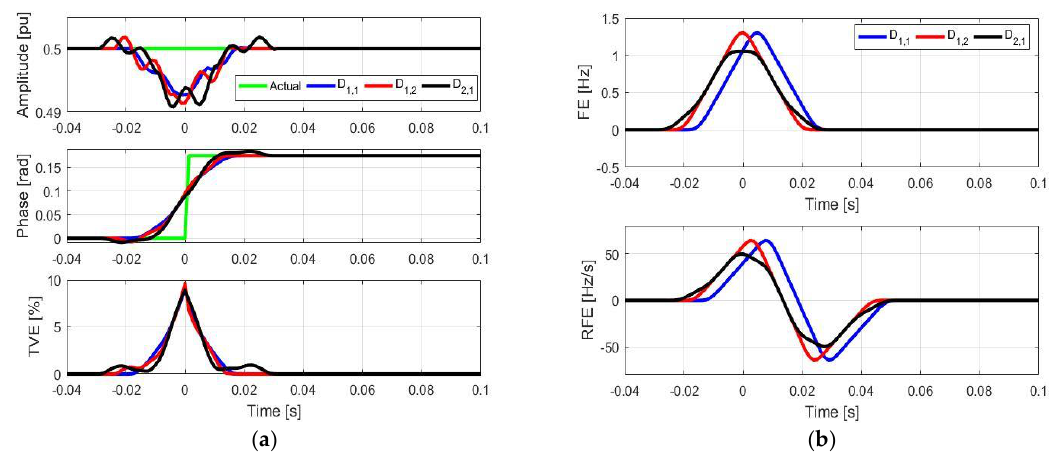
Figure 8. Simulation results obtained for the amplitude step signal, for 𝐾 = 1 for 𝐷 1,1 = 16 and 𝐷